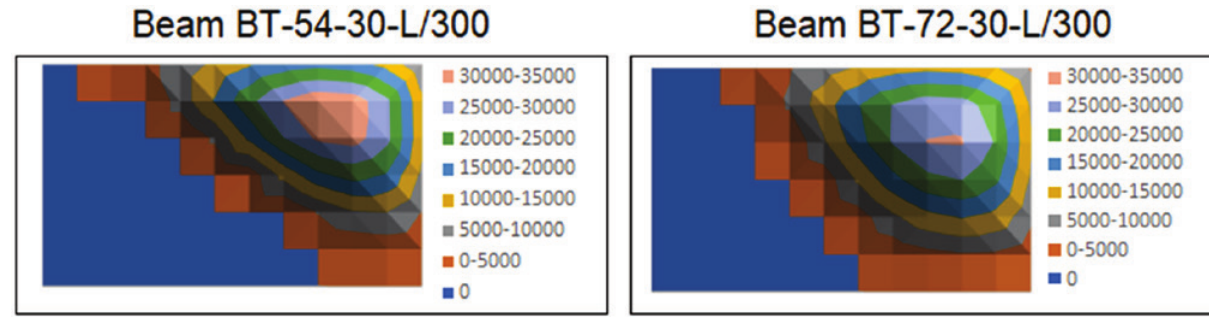
Figure 19 Lift-off of beam BT-54-30-L/300 and BT-72-30-L/300 onto the bearing pad and reaction on springs